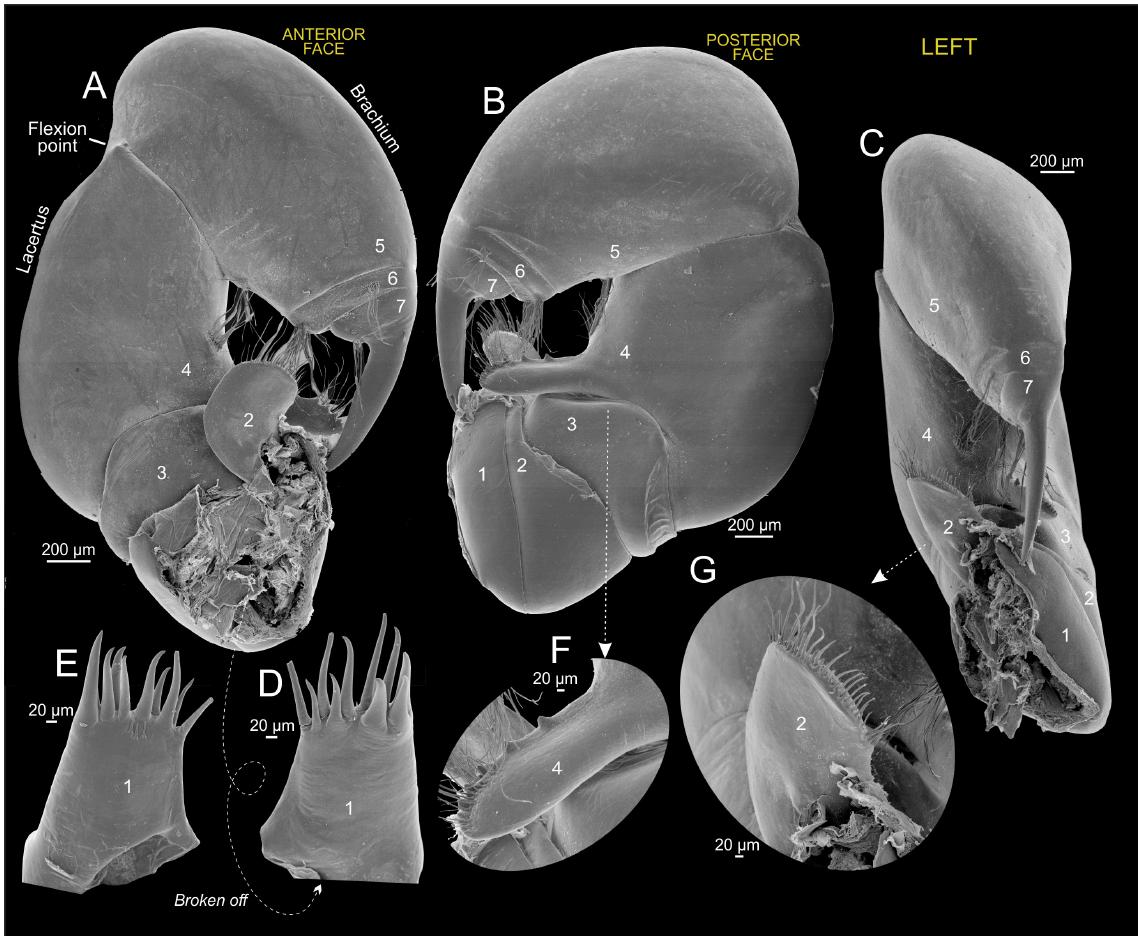
Fig. 6. Godzillius louriei sp. nov., holotype (NHMD 669698), left maxilla 1 (mx1), scanning electron microscopy. A . Anterior face of mx1. B . Posterior face of mx1. C . Apical view of mx1. D – E . Endite of segment 1, unintentionally removed during dissection. F . Conical spines along the surface of the digitiform endite on segment 4, posterior view. G . Spatulate endite of segment 2, apical view. Small numbers represent segments of